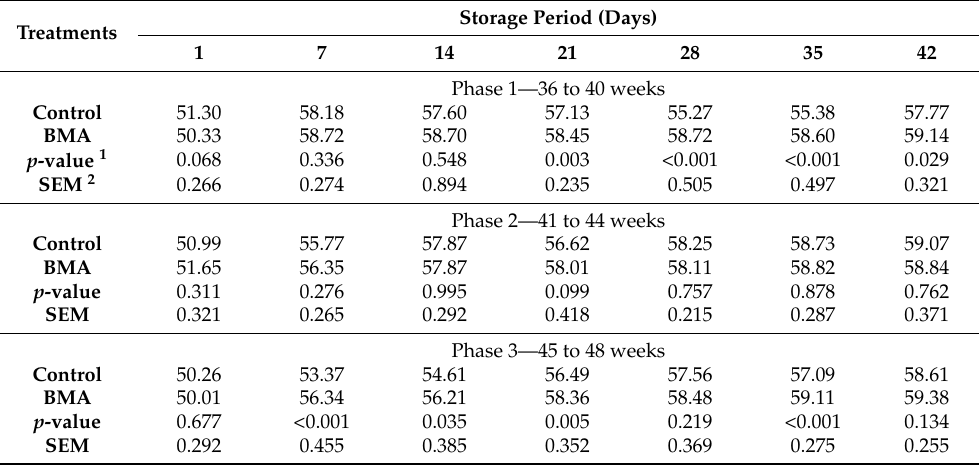
Table 5. Yolk lightness (L* color) of eggs from laying hens fed with β -mannanase depending on storage